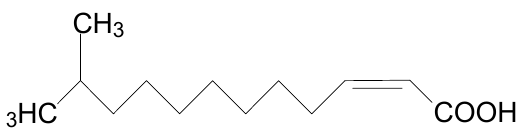
Figure 2. Chemical structure of diffusible signal factor (DSF).